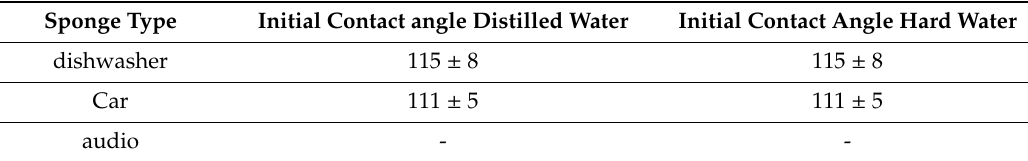
Table 3. Initial contact angle of droplets of each water type on each sponge type.